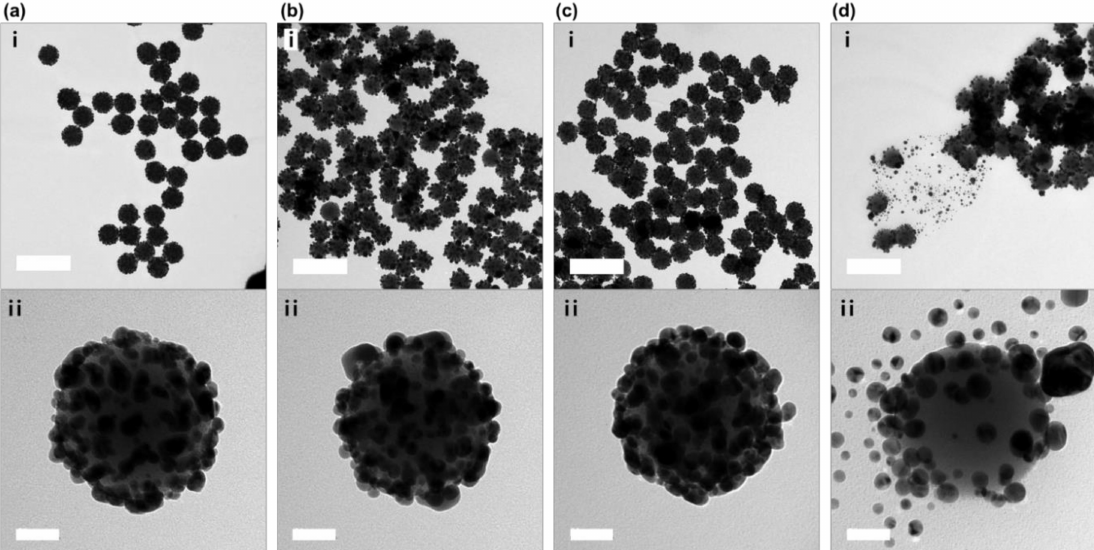
Figure 2. TEM images of SiO 2 @Ag NPs immobilized with three kinds of ligands. ( a ) Bare SiO 2 @Ag NPs, ( b ) SiO 2 @Ag@cysteinyl- β -CD NPs, ( c ) SiO 2 @Ag@EDA- β -CD NPs, and ( d ) SiO 2 @Ag-PEG